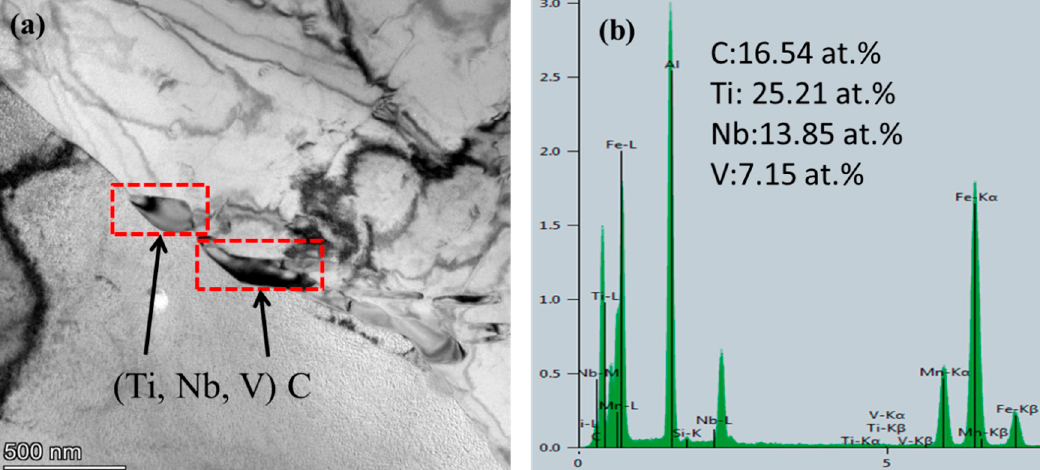
Figure 14. Images of (Ti, Nb, V) C precipitates in the experimental steel at 650 °C after five passes of thermal simulation. Images of ( a ) (Ti, Nb, V) C precipitates and ( b ) EDS of Nb, V, and Ti.